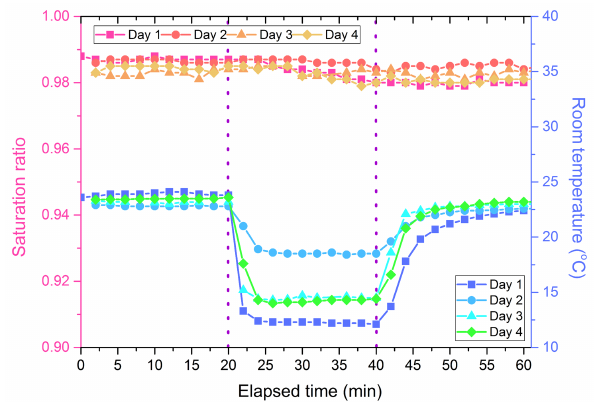
Figure 6. SR-calc and room temperature as a function of elapsed